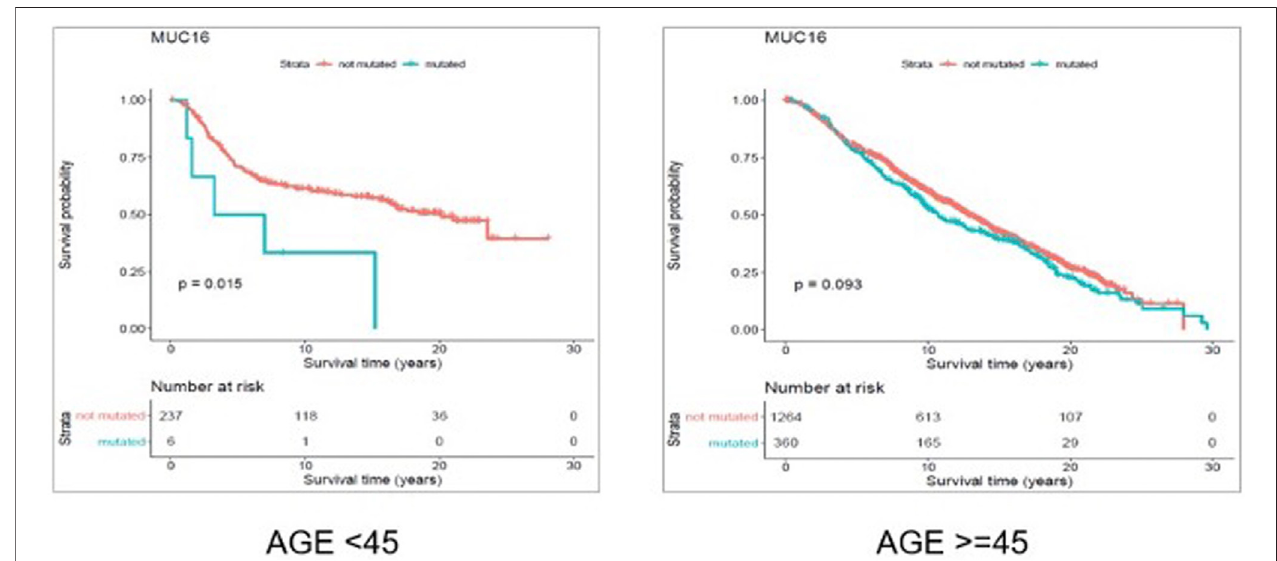
FIGURE7| Resultsfromoverallsurvival(OS)analysiscomparingthesurvivaltimeofbreastcancerpatientspossessingamutatedorun-mutatedMuc16gene.The differencebetweenthetwogroups(withandwithoutmutationsinMuc16gene)issigni fi cantamongyoung(under45 yearsofage)individuals( p -value (cid:1) 0.011),whilenot signi fi cant in older patients ( p -value (cid:1)